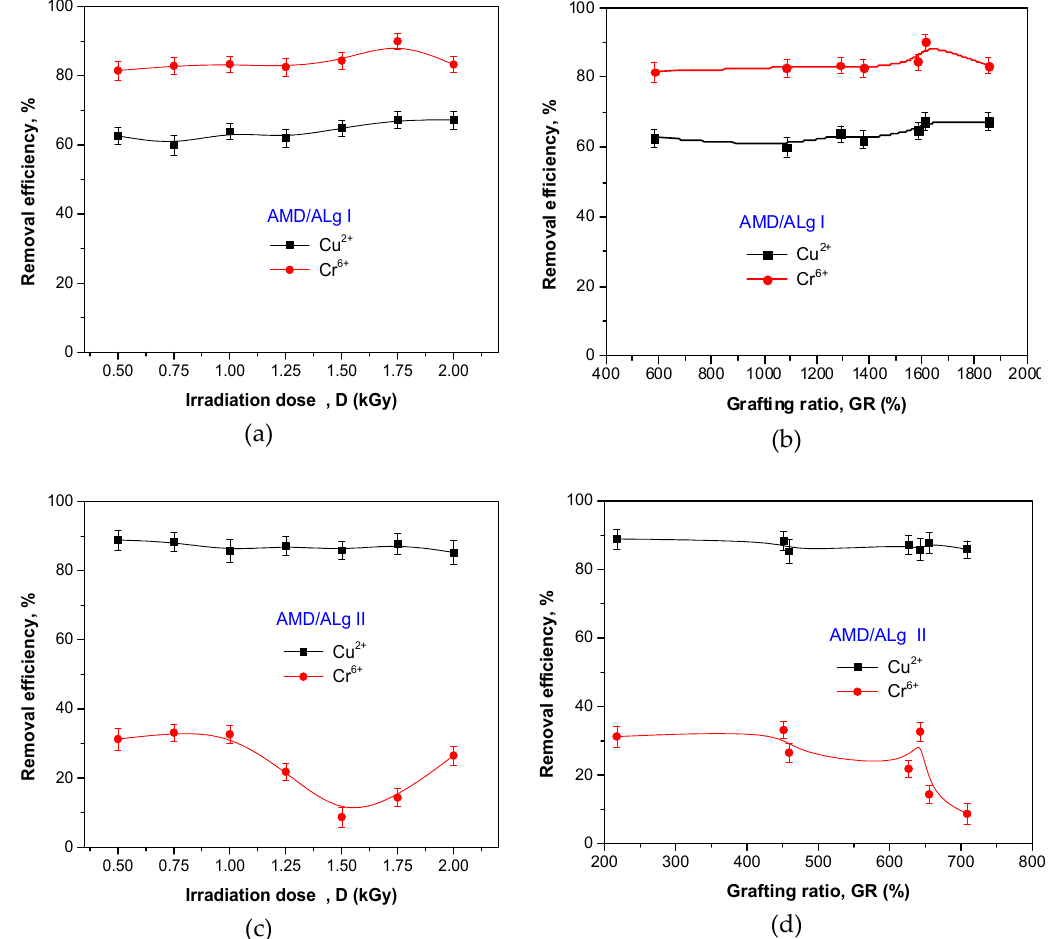
Figure 11. The influence of irradiation dose, grafting ratio, and sodium alginate concentration on Cu 2+ and Cr 6+ ion removal efficiency. ( a ) removal efficiency versus irradiation dose for AMD/ALg I samples; ( b ) removal efficiency versus grafting ratio for AMD/ALg I samples; ( c ) removal efficiency versus irradiation dose for AMD/ALg II samples; ( d ) removal efficiency versus grafting ratio for AMD/ALg II samples.